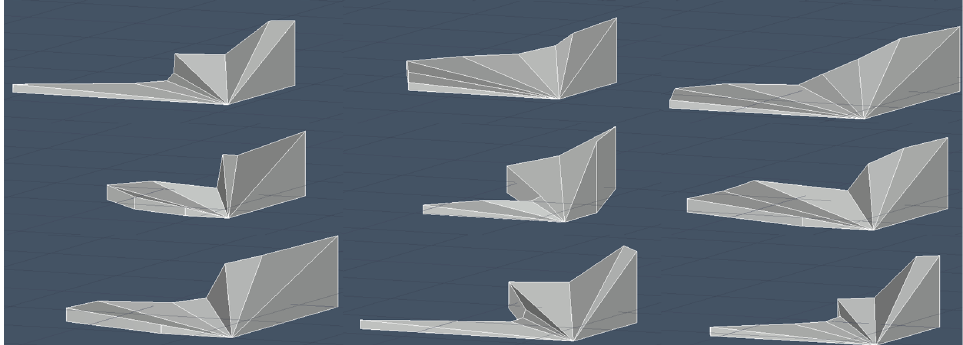
Figure 3. Complex polyhedra for the defined alternatives. Table 7. Volumes of the complex polyhedra and ranking of the alternatives.